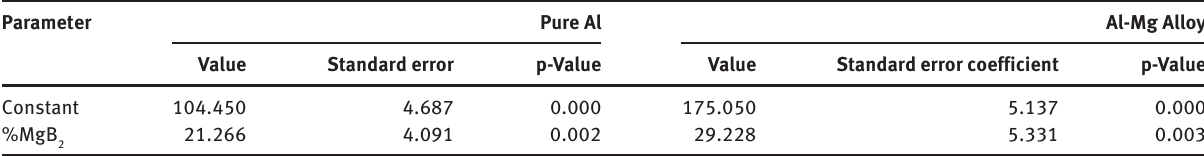
Table 2: ANOVA of the model ultimate tensile strength.